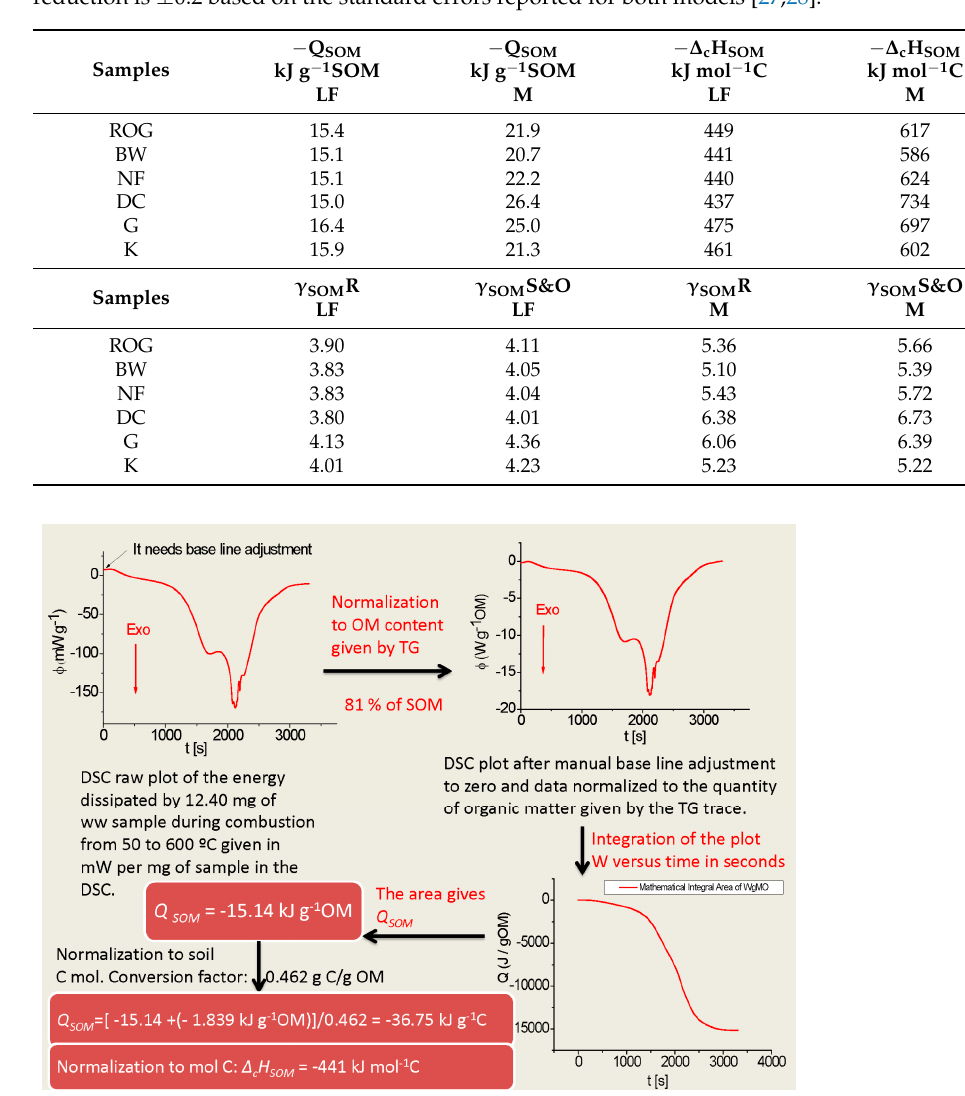
Figure 1. A summary of the procedure followed to approach the enthalpy of combustion of SOM, ∆ c H SOM , by simultaneous DSC–TG.